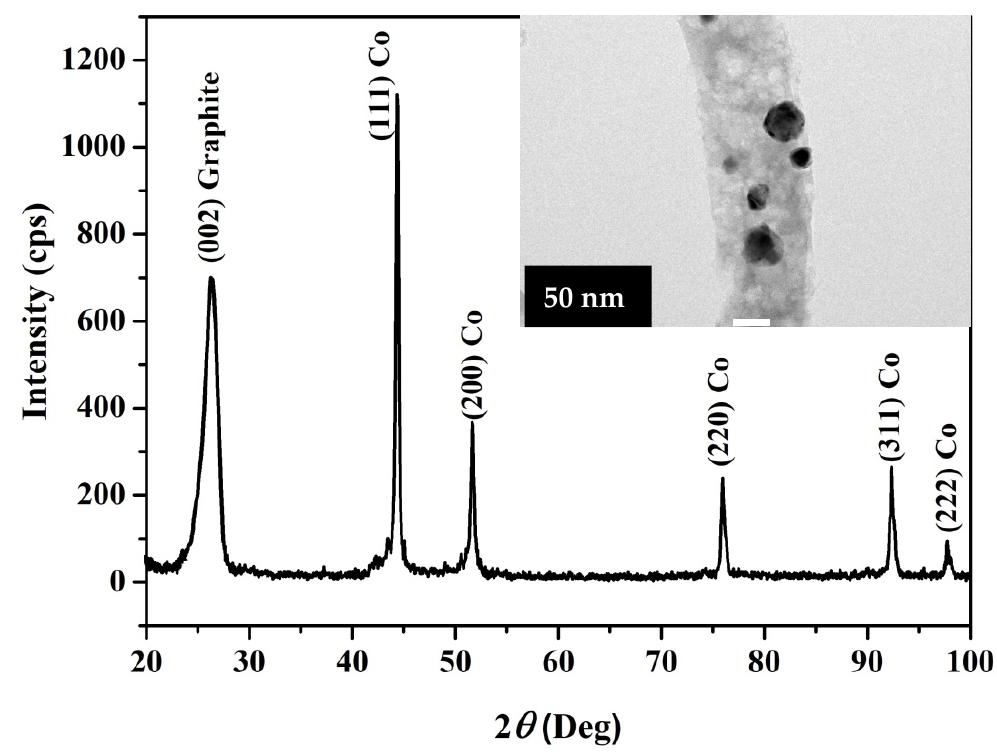
Figure 2. XRD pattern for the prepared Co-incorporated carbon nanofibers. The inset displays the TEM image of the prepared Co-incorporated carbon nanofibers.